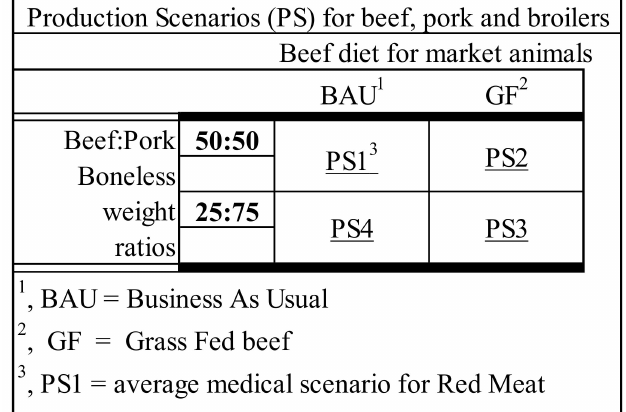
Figure 2. Two-by-two decision matrix for describing four livestock production scenarios (PS) for beef, pork and